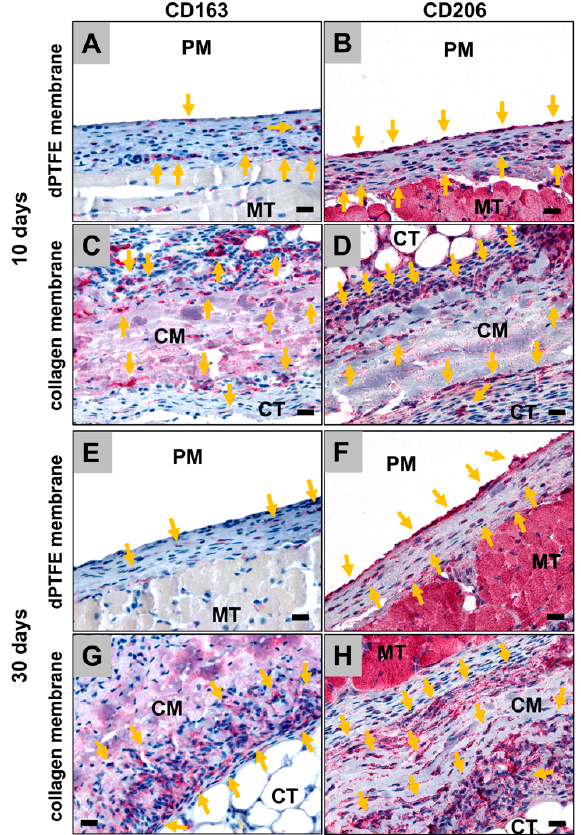
Figure 2. Exemplary images of the detection of M2 (CD163) and M1 (CD206) positive macrophages (yellow arrows) into the implantation beds of the dPTFE and the collagen membrane at day 10 ( A – D ) and day 30 ( E – H ) after implantation (all images: 400× magnification, scale bar = 20 µm).